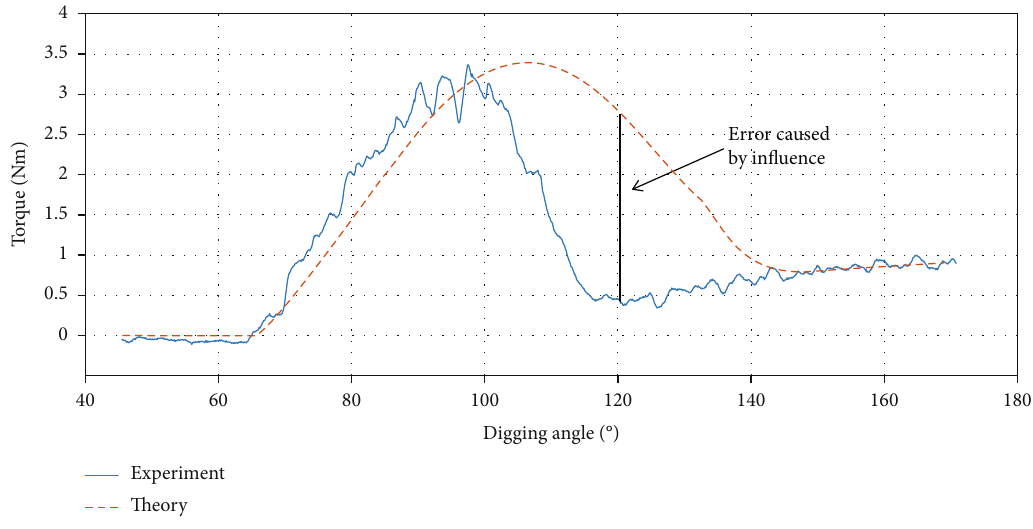
Figure 2: Error caused by ignoring the change of the mechanical properties in the in fl uence